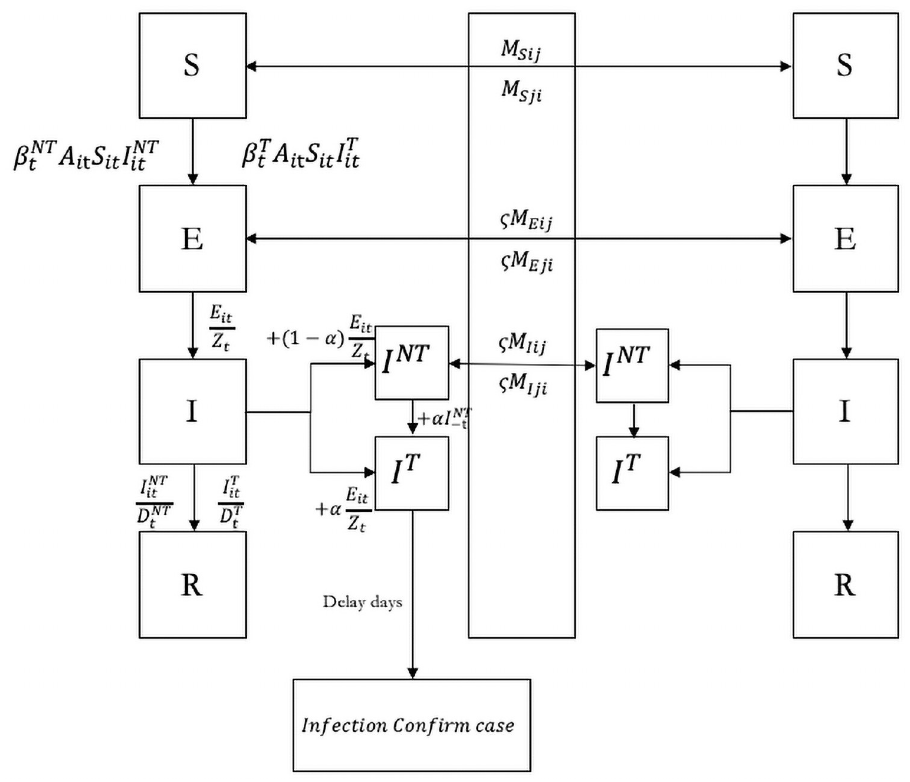
Fig 1. SEIR model. Graphical scheme representing the interactions among different stages of infection in SEIR Model. , I NT and N it denote the susceptible, exposed, detected infected, undetected infected and total In this model, S it , E it , I T it it population in city i and time t . b NT and b T are the rate of transmission for undetected infected individuals and detected t t infected individuals, respectively. α t is the testing rate in time t. Z t denotes latency period through which patients switch from exposed stage to infection stage. A it is within-city population flow in city i in time t. Spatial spread of the disease is governed by the daily number of people travelling from city j to city i in time t( M ). ijt